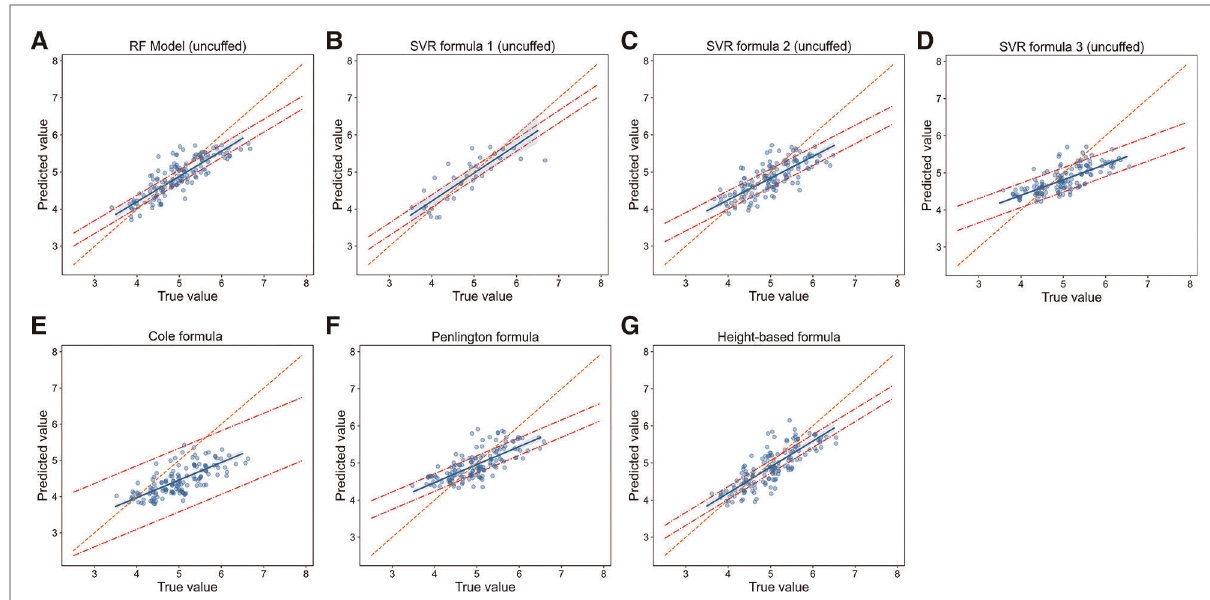
FIGURE 5 Relationship of predicted values and true values in uncuffed ETT size prediction (model vs. Formulas). Scatter plots show the relationship of optimal ETT size (x-axis) vs. predicted ETT size (y-axis) for uncuffed ETT size prediction with RF model ( A ), SVR formulas ( B-D ) and traditional formulas ( E-G ). The blue line represents the linear regression line, and the orange line represents the standard line for absolutely accurate prediction. The area between the two red dashed lines represents the 95% CI (con fi dence interval). RF=random forest, SVR=support vector